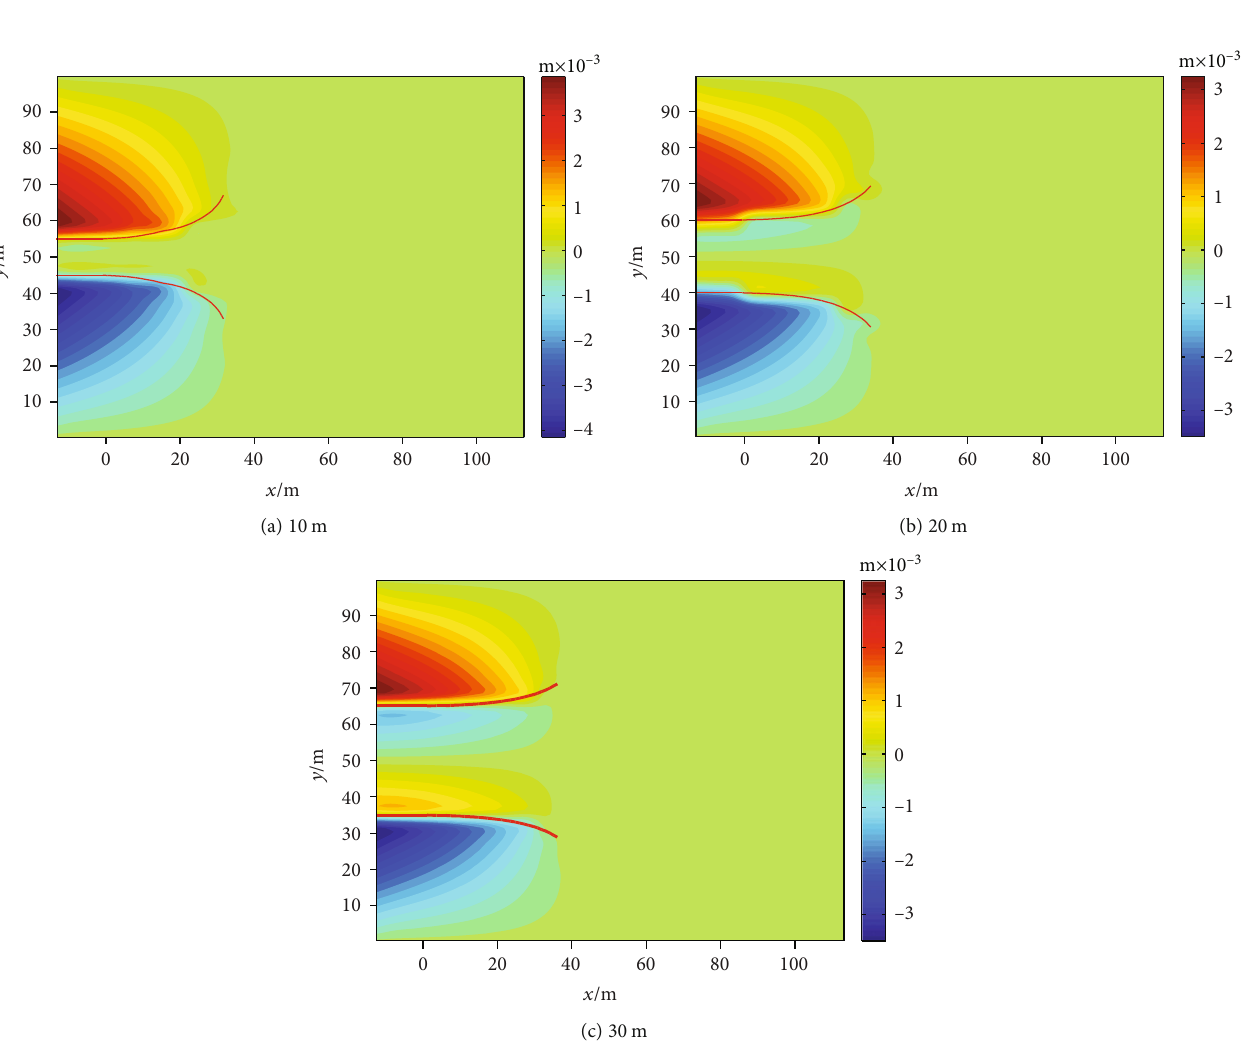
Figure 10: Displacement distribution of simultaneous propagation in single well under di ff erent